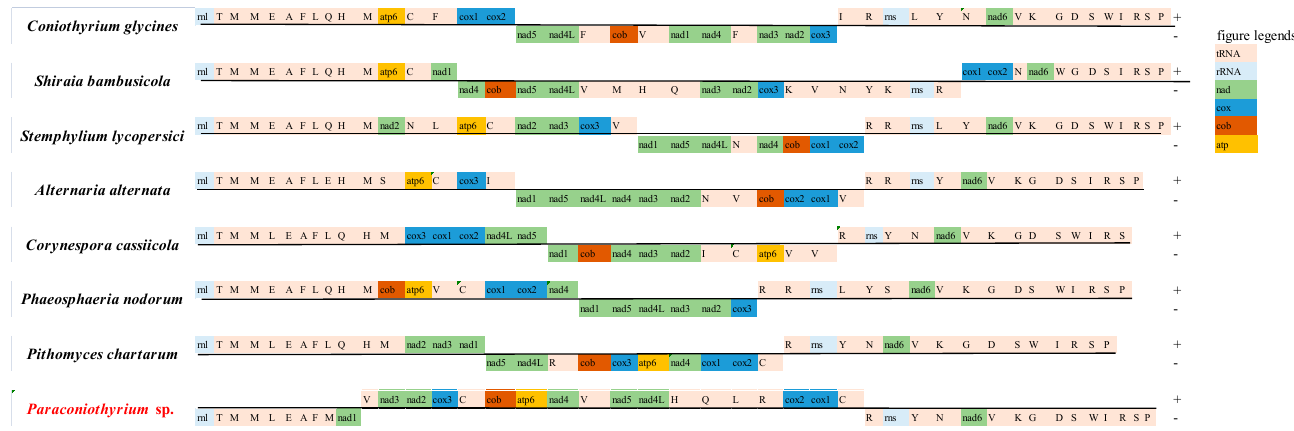
Figure 5. Mitochondrial gene order rearrangements among 8 Pleosporales species. The genes on the H-strand (+) were shown above the line, and the genes on the L-strand ( − ) were shown below the line.